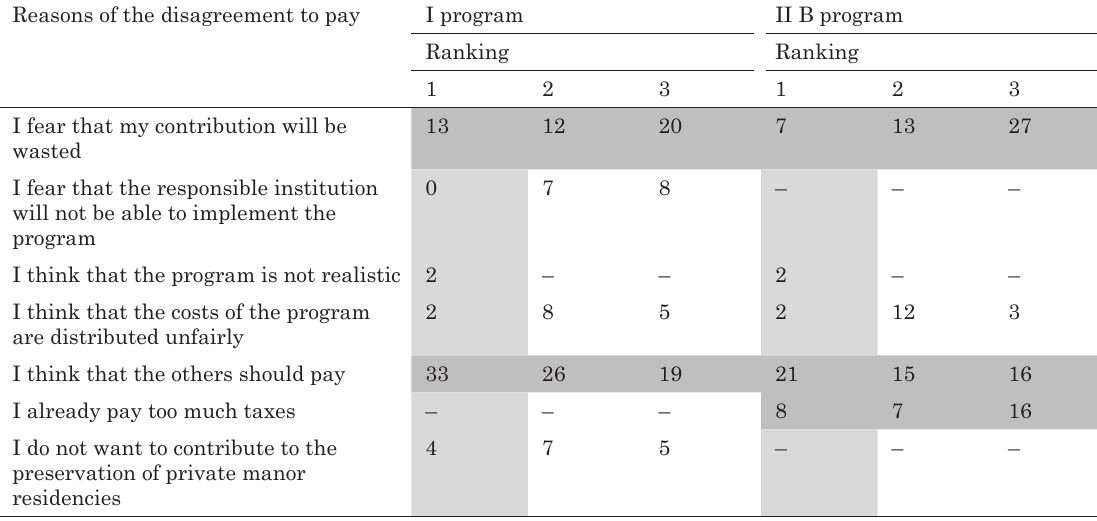
table 4. The protest answers ranked by the respondents (1 – the most significant reason of the disagreement to pay*; 3 – less significant